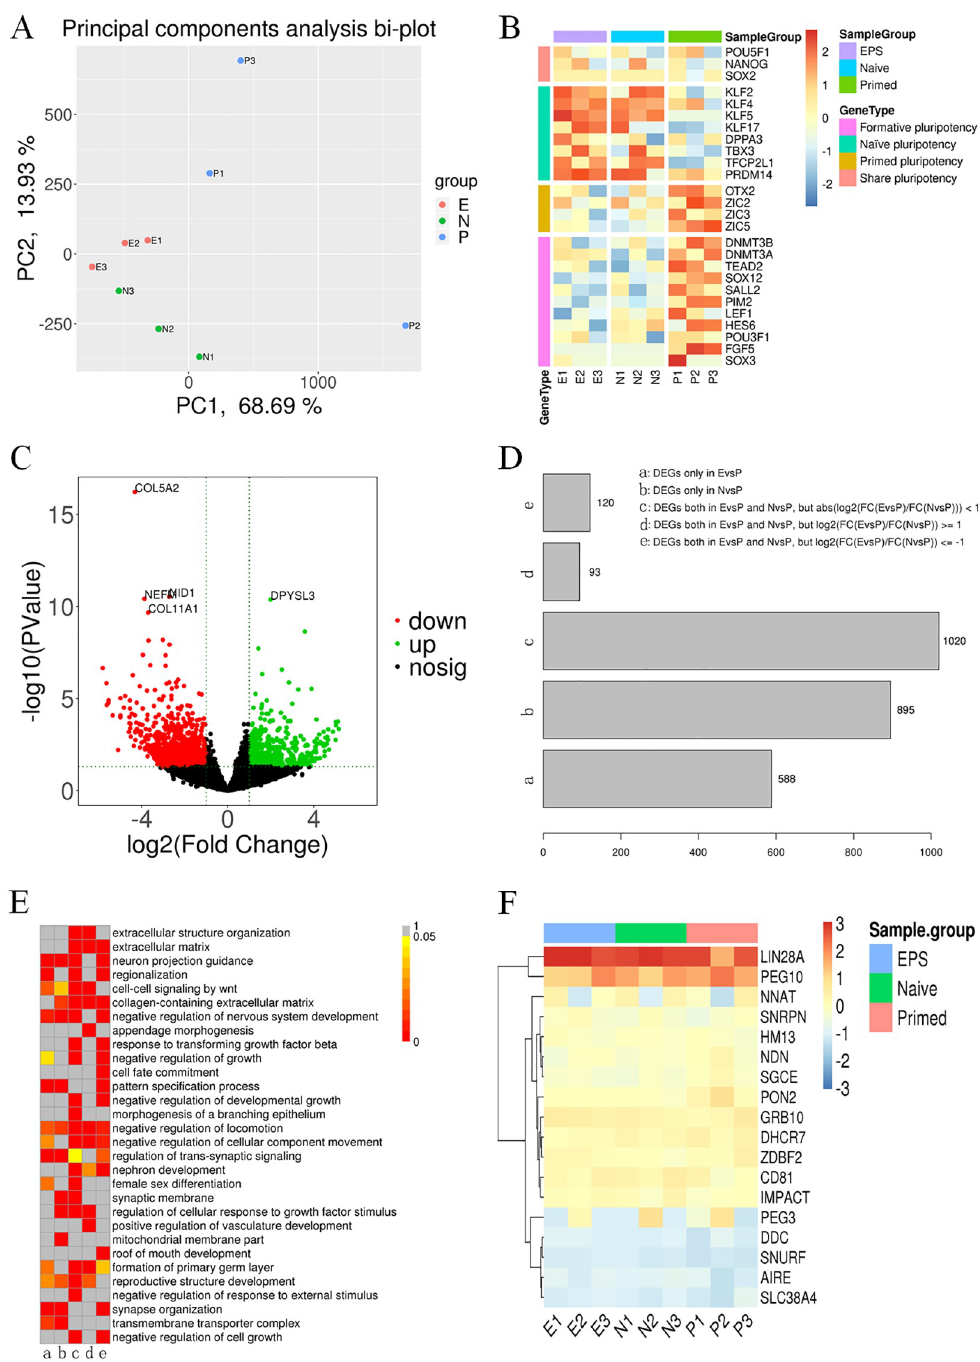
Fig 3. Genome-wide expression analysis of parental primed hESCs and converted naive hESCs in different conversion conditions. (A) PCA based on DEGs revealed that the transcriptomes of naive hPSCs and hEPS cells were similar. (B) Expression of genes identified by others as associated with the naive, EPS cells and primed states in humans. Expression levels, as determined by RNA-seq. (C) Volcano plot labeling DEGs. Volcano plot indicated upregulated and downregulated DEGs between EPS cells, naive cells and primed cells. Red dots represent genes with significantly downregulated expression, green dots represent genes with significantly upregulated expression, while black dots represent genes with no significant difference. (D) DEGs divided according to different groups. A and B represent the number of DEGs in na ï ve and EPS compared to primed hPSCs, separately. C, D, E represent comparing to primed, the number of DEGs that na ï ve and EPS hPSCs shared. (E) GO enrichment terms of DEGs in (D). P values are indicated in the corresponding lattice. (F) Imprinted genes reveal the change in epigenetic status between reverted cells and their origins.